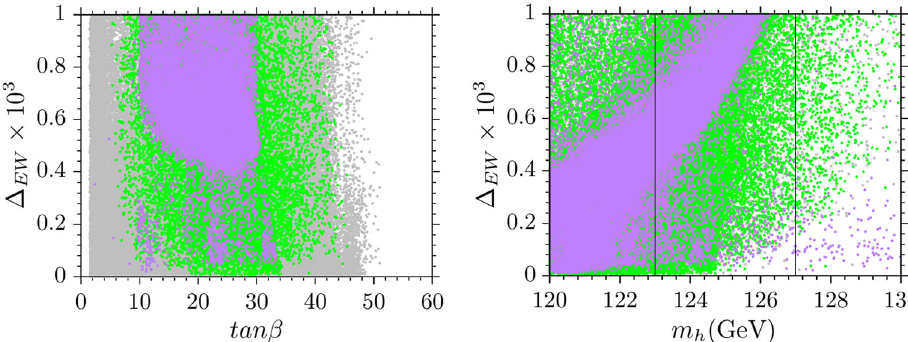
Fig. 2 Plots in (cid:2) EW − tan β and (cid:2) EW − m h planes. The color coding not apply the Higgs mass bound in the (cid:2) EW − m h plane, since it is is the same as Fig. 1. In addition, the purple points form a subset of represented in one axis. We use rather vertical lines which shows the ≤ 700 GeV. We do green and they represent the solutions with m ˜ t experimental bounds on the Higgs boson mass. 1